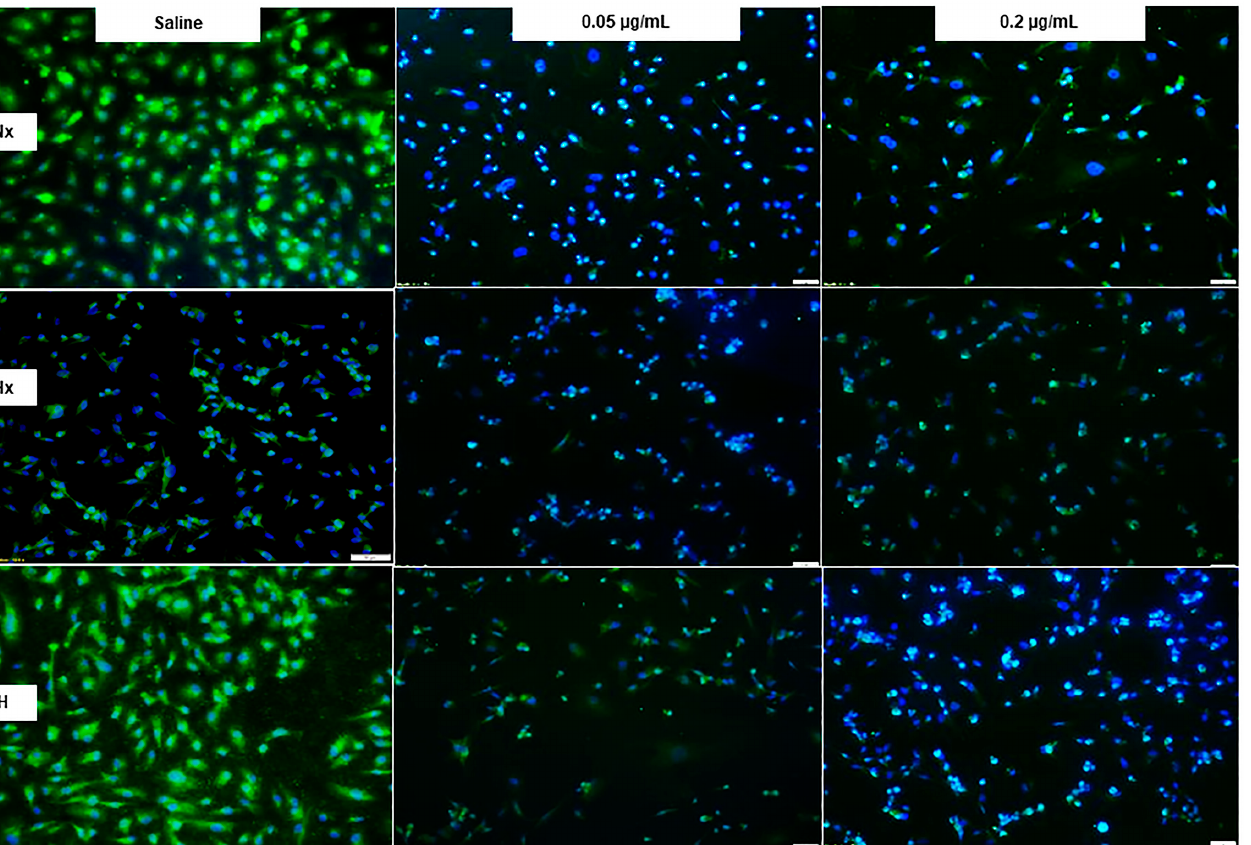
Figure 6. Representative images of the effect of bumetanide on VEGFR-1 immunoreactivity (green) counterstained with DAPI (blue) in cultured human microvascular retinal endothelial cells (HMRECs) exposed to normoxia (Nx), hyperoxia (Hx, 50% O 2 ), or intermittent hypoxia (IH) for 72 h. Images were captured at 20 × magnification (scale bar is 50 µ m). Quantitative analysis of VEGFR-1 immunoreactivity is presented in Table 1.